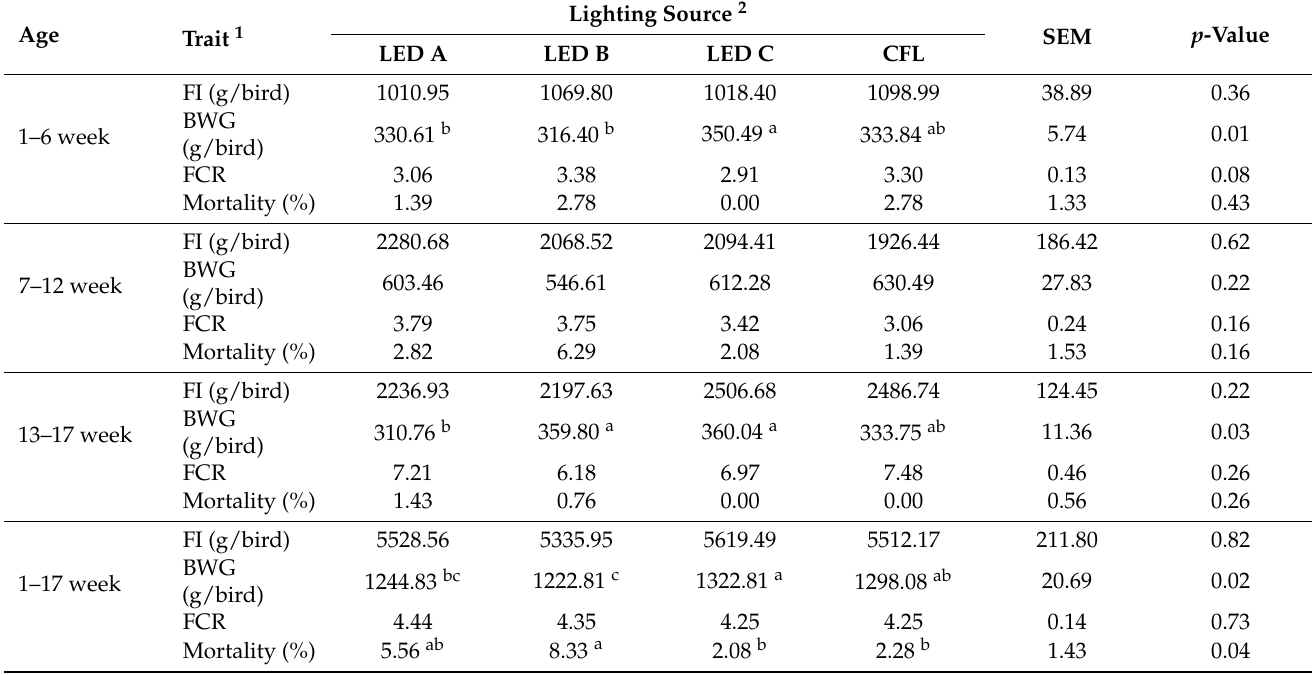
Table 3. Effect of lighting sources on growth performance of Beijing-You pullets.